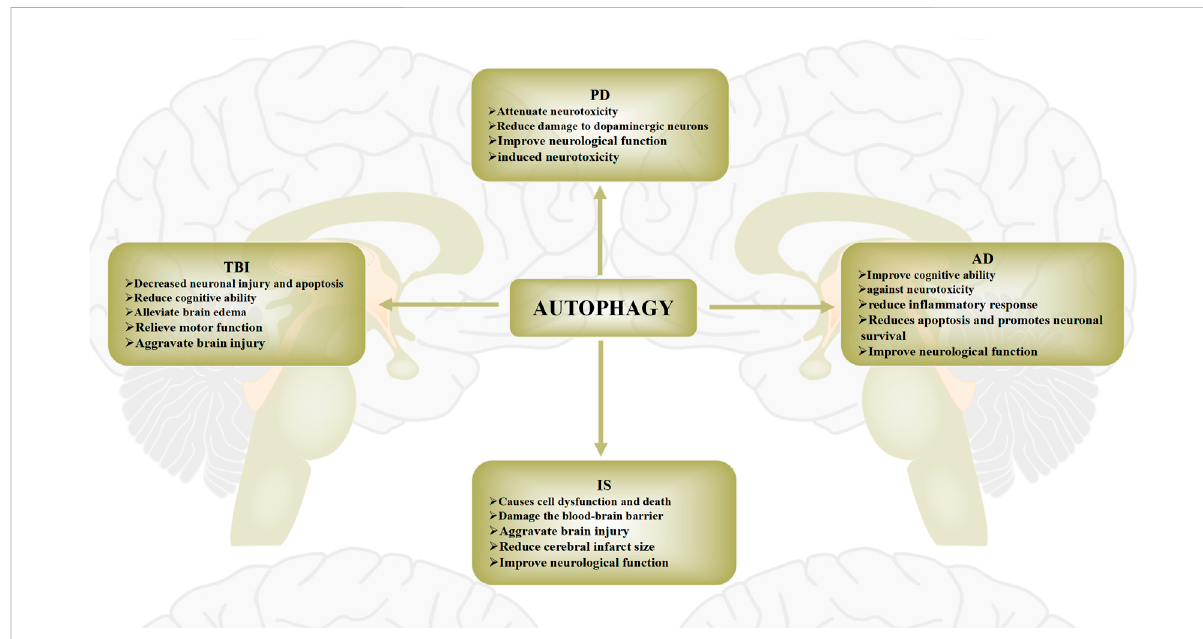
FIGURE 3 Role of autophagy in brain injury diseases. The role of autophagy in brain injury diseases has recently been widely reported. Protective and pathogenic roles of autophagy in these diseases have been proposed. The role of autophagy in brain injury diseases is widely regarded as a “ double- edged sword ” . Autophagy activation after brain injury removes necrotic substances, thereby preventing cerebral ischemia damage and promoting cell survival. Conversely, activation of autophagy may also further aggravate brain damage, leading to cell